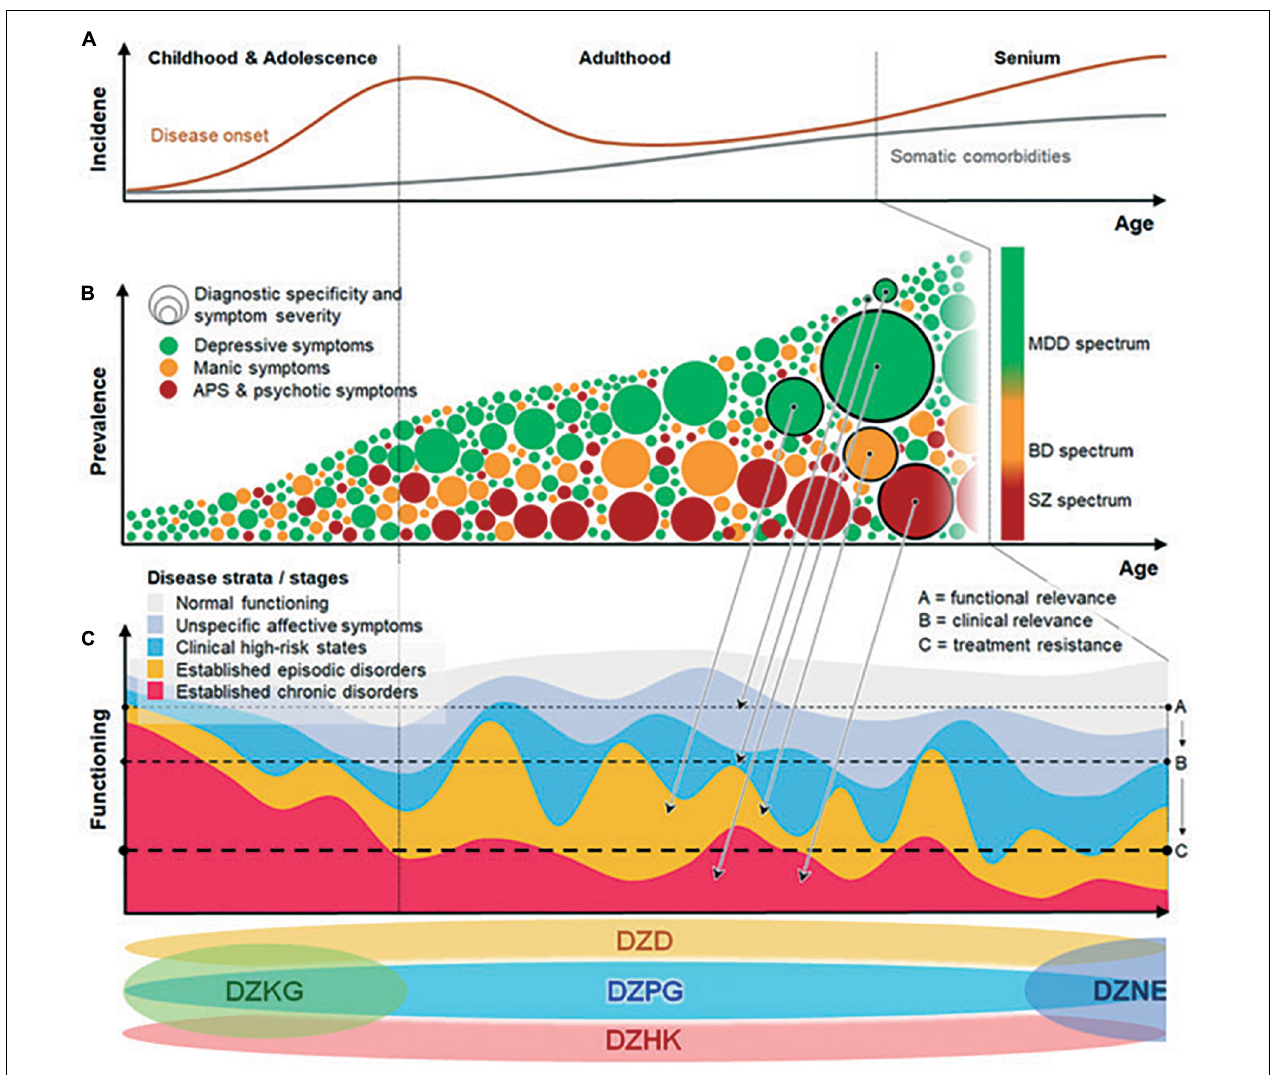
FIGURE 2 | Concept figure illustrating the dynamics of mental disorders from a life-span perspective: (A) Incidence increases between adolescence and adulthood and toward old age. (B) Disease phenotypes evolve from non-specific to specific/severe manifestations. Arrows from panels (B) to (C) indicate how specificity/severity of phenotypes relates to disease strata. Heterogeneity increases as progressive and non-progressive trajectories, ranging from highly disabling phenotypes to minor impairments, mix at the population level. (C) Increasing functional impairment with disease progression from unspecific, at-risk to established episodic or chronic disease strata. At the bottom of the figure the positioning of different German Centres of Health covering mental healthcare-relevant topics across the lifespan are depicted. BPD, bipolar disorder; CHR, clinical high risk; DZD, German Center for Diabetes Research; DZHK, German Center for Cardiovascular Research; DZKJ, German Center for Child and Adolescent Health; DZPG, German Center for Mental Health; MDD, major depressive disorder; and SZ,